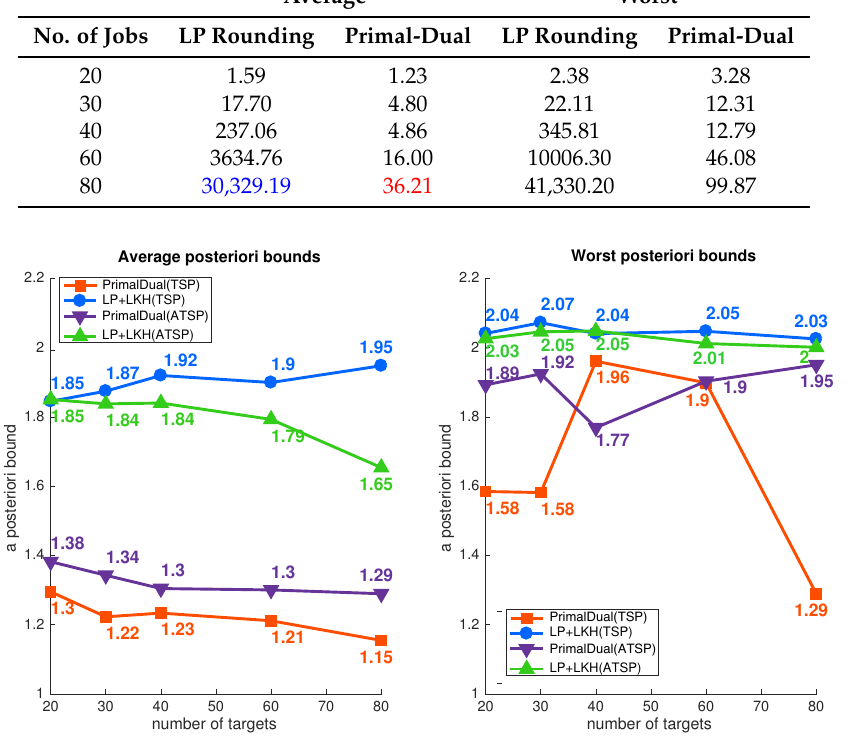
Figure 3. Posteriori bounds of 50 instances for each problem